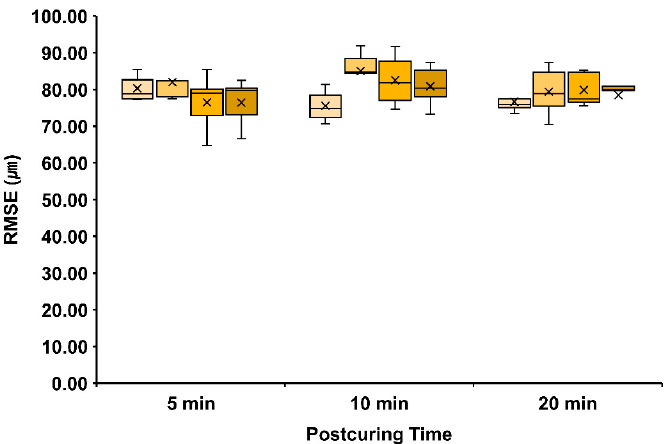
Figure 4. Accuracy of the three-unit bridge. Data are median root-mean-square error (RMSE) values, which did not differ significantly according to the intensity ( p > 0.005, Mann–Whitney with Bonferroni’s correction) and time of post-curing ( p > 0.0083, Wilcoxon test with Bonferroni’s correction). X mark means the average value of the data.